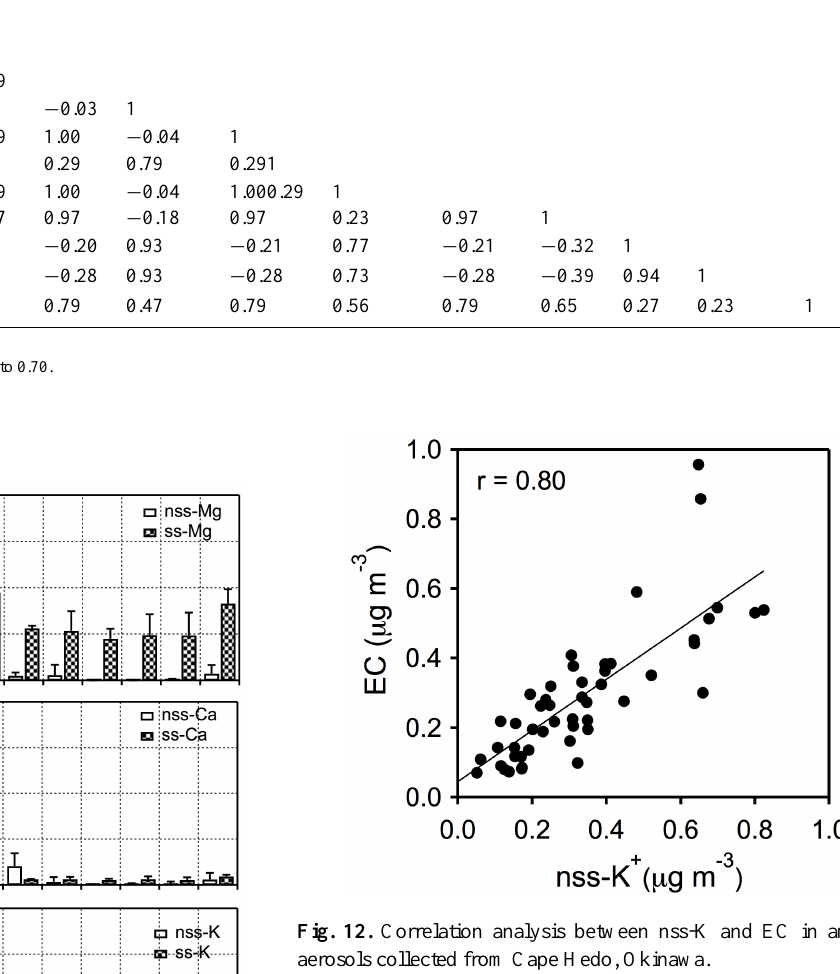
and K + are the cations that neutralize acids. The role of Cl − in acid production is negligible because Cl − mainly comes from the ocean as sea salt. We calculated NF and using fol- lowing formula (Keene et al., 1986).